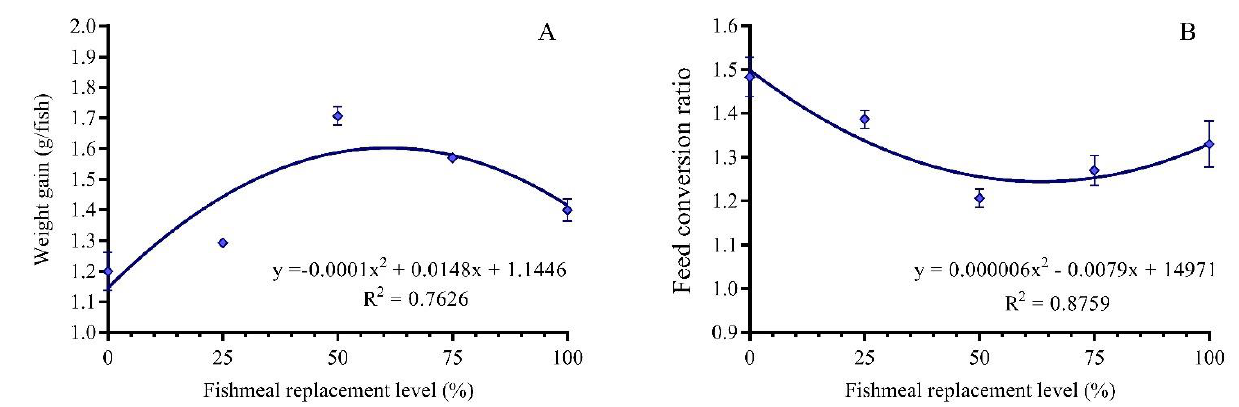
Figure 1. The fit regression model of increasing fishmeal substitution levels by amphipod meal of weight gain ( A ) and feed conversion ratio ( B ) of Mugil cephalus .